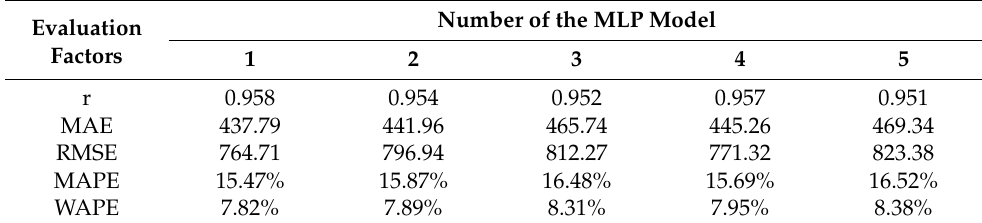
Table 7. Comparisons of forecasting accuracy for analyzed models.